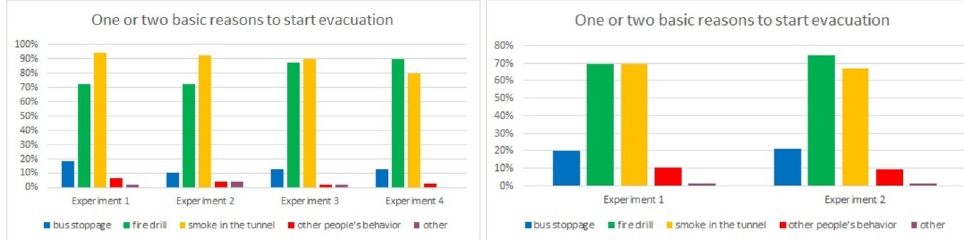
Fig 10. Survey results in question about decision premises to start evacuation–question 1. (Results from Laliki experiment are on the left side, from Gda ń sk on right).